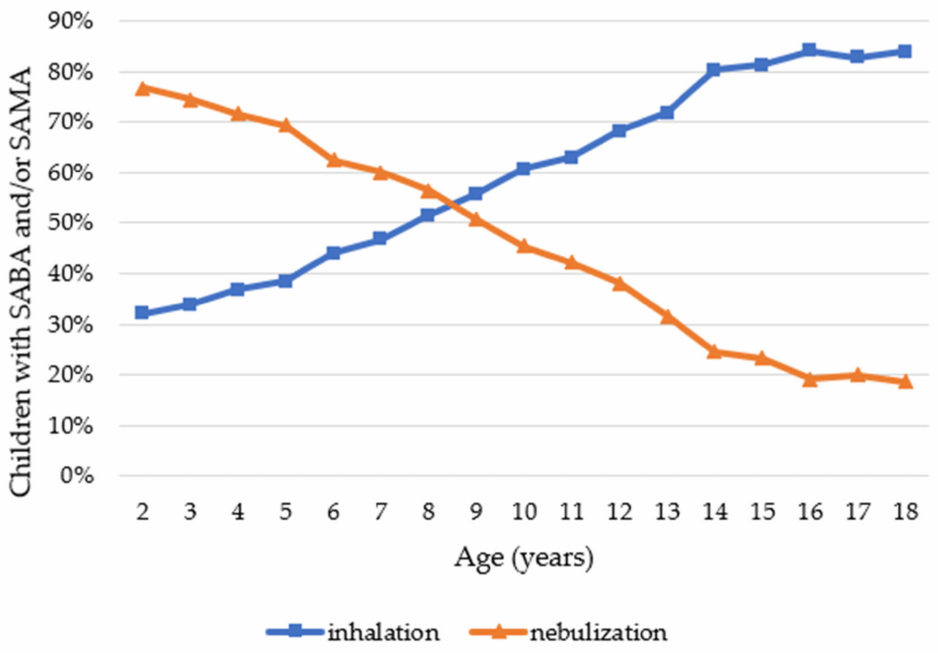
Figure 4. Proportion of children using a nebulizer and/or inhaler among all children who have taken at least one SABA or